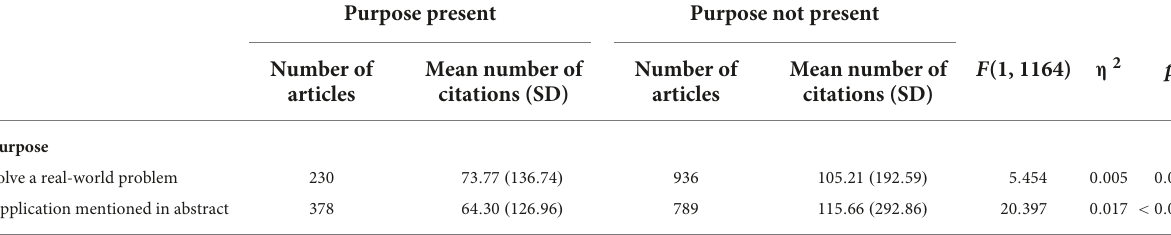
TABLE 5 Mean number of citations across purposes.